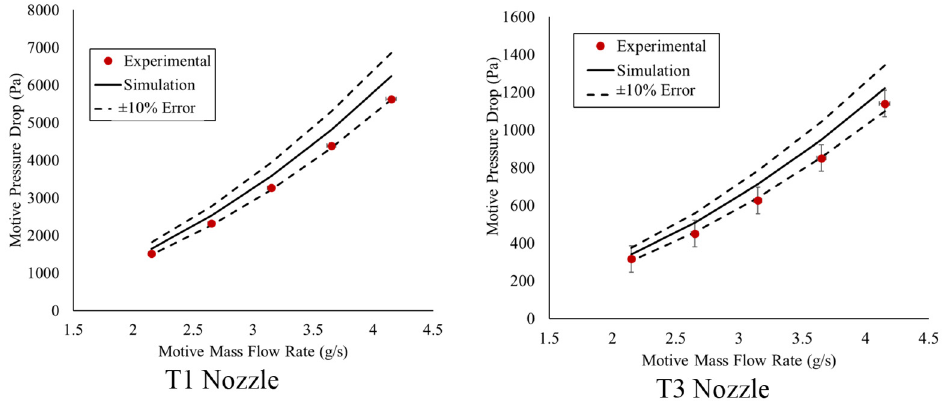
Figure 7. Motive pressure drop (Pa) vs. motive mass flow rate (g/s) for steam tests. See Table 3 for nozzle geometry details.